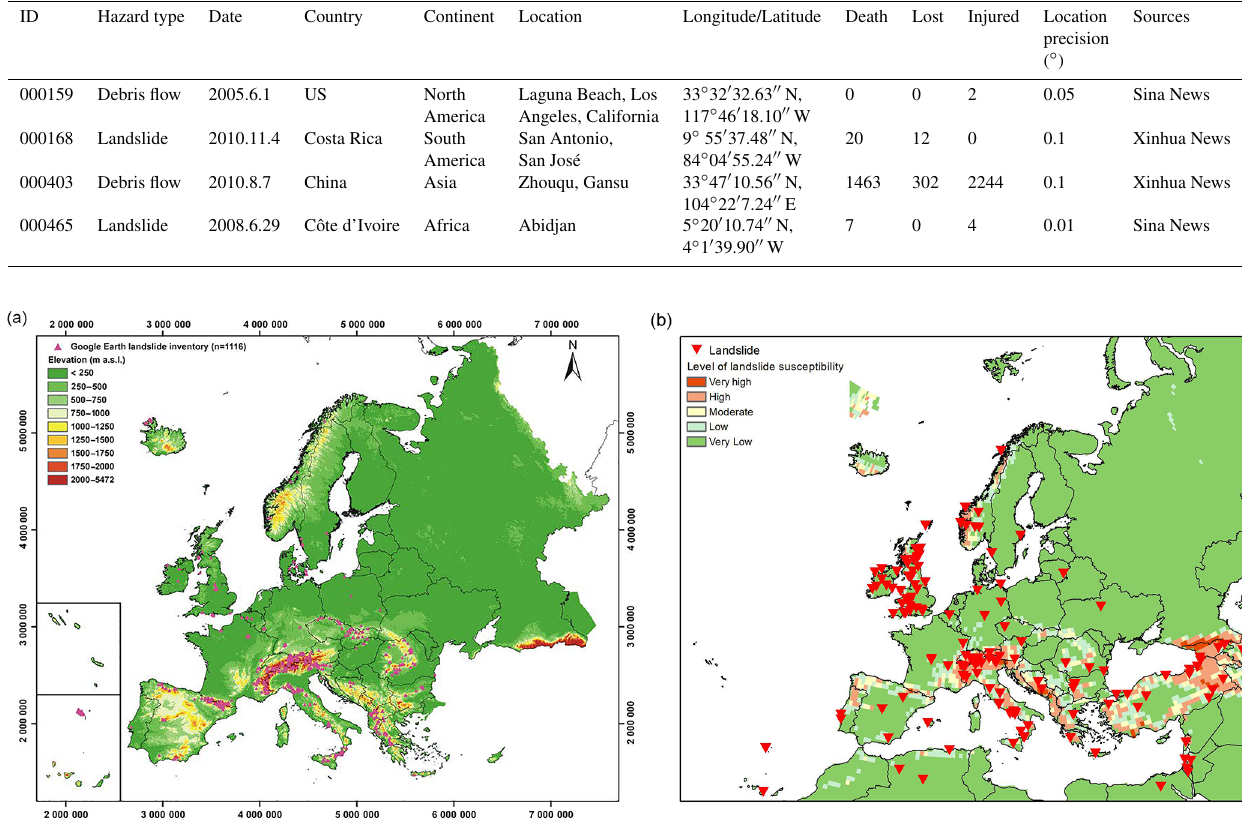
Figure 2. Comparison of landslide overlay in